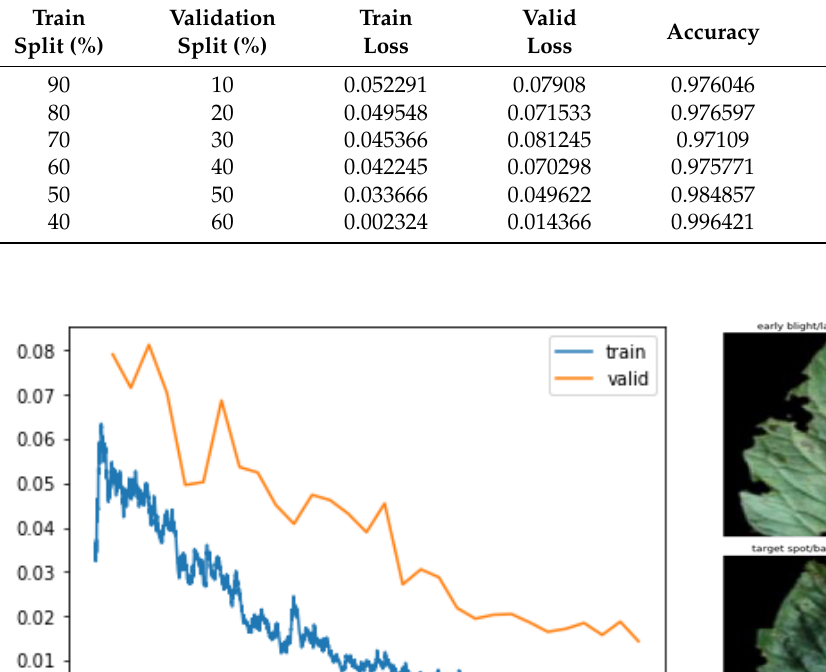
Table 4. Results for various train-validation split ratios.